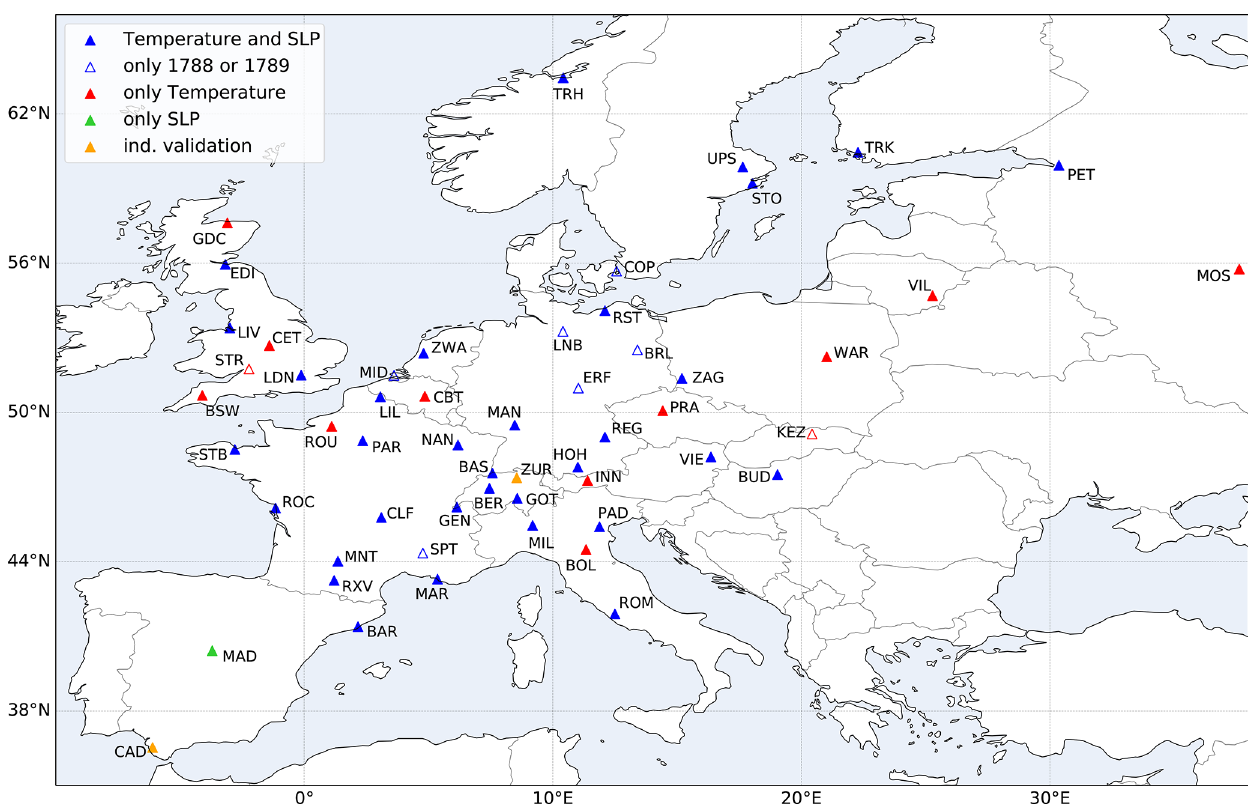
Figure 1. Map of stations included in the reconstruction. Distinction is made between stations with series with both temperature and SLP (blue) and those with just one of these variables (red and green, respectively); also shown are stations with data for either just November– December 1788 or January–February 1789, as well as stations used for an independent validation